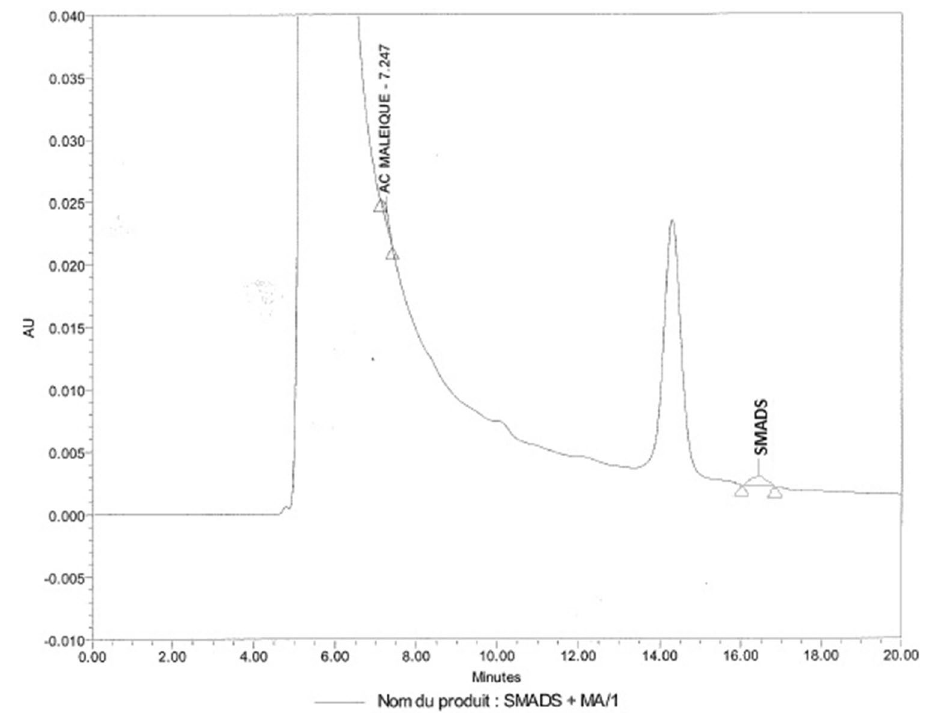
Fig. 5 HPLC of MA-SMADS copolymer